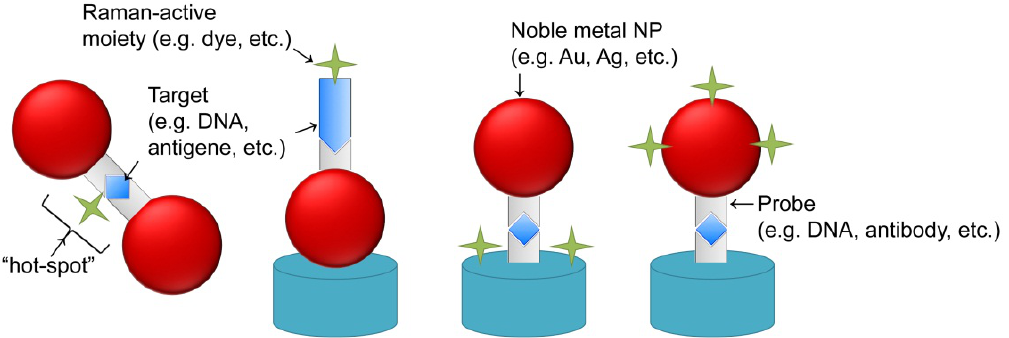
Figure 2. Examples of different variations of cross-linking approaches for SERS. The schematics depicts different approaches to the use of Raman-active moieties to enhance SERS signal output via cross-linking strategies: the Raman-active moiety can be bond to the target (two illustrations to the left) or to the surface of the film and/or NP (two illustrations to the right). Signal enhancement will occur upon cross-linking of the involved moieties derived from target recognition and